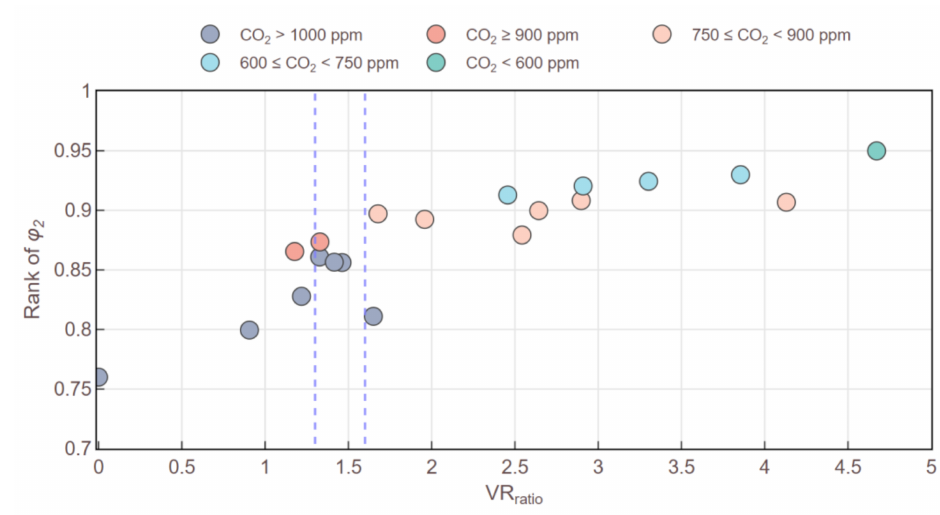
Figure 8. Scores of ϕ 2 and VR ratio of the investigated cases.